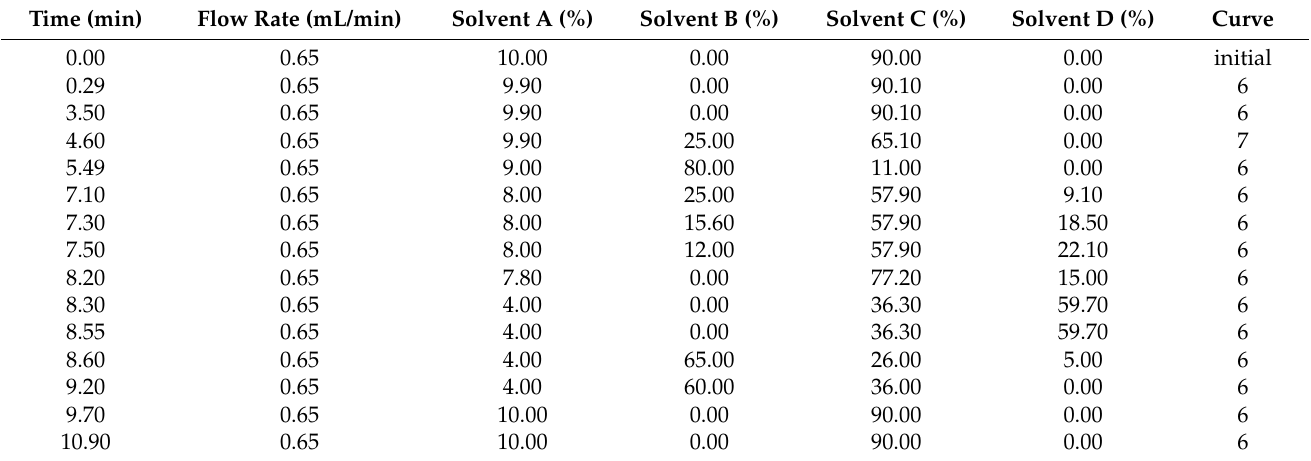
Table 4. Elution profile parameters. Solvent A: 100% AccQ-tag Ultra eluent A, solvent B: 10%